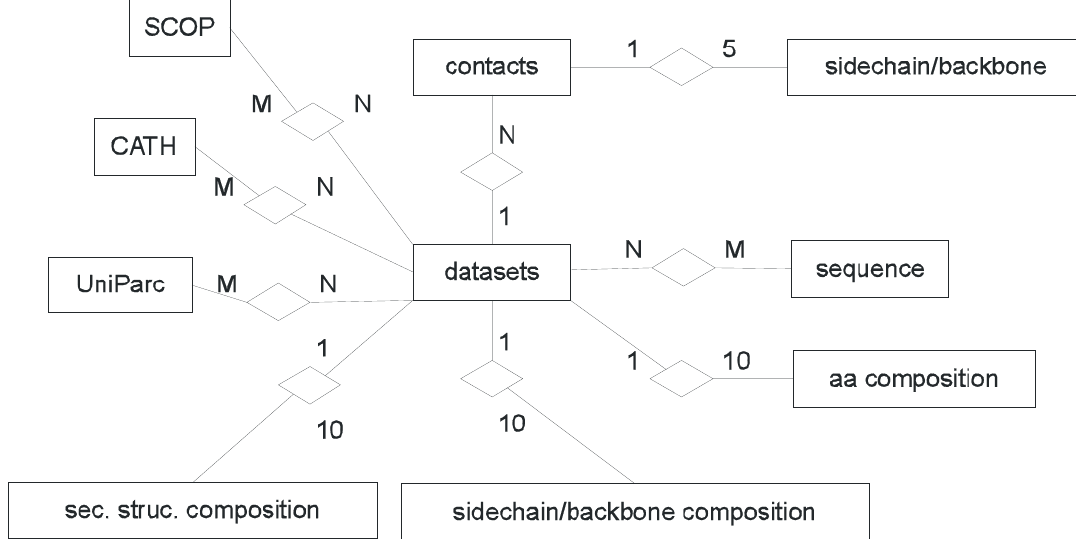
Figure 1: ER-diagram. ‘datasets’ is the central entity in the schema and represents the interfaces. Every interface may be assigned more than one CATH, SCOP and UniParc classification and vice versa. Therefore the classification-entities are linked with datasets by an N:M-relation. Every interface in datasets consists of a number of amino acid pairs that are represented by the ‘contacts’-entity. A contact pair exhibits a number of side- chain/backbone compositions depending on the distance criterion. As we consider a range between 4Å and 8Å in steps of 1Å, we have a 1:5 relation. Similarly the relations between ‘datasets’ and ‘aa composition’, ‘sec. struc. composition’ and ‘sidechain/backbone composition’ come about. In addition to the range, the number of chains has to be taken into consideration resulting in a 1:10 relation. An interface including the chain consists of a number of residues. A residue may belong to more than one interface if the commensurating chain is involved in more than one interaction. This leads to the N:M relation between ‘datasets’ and